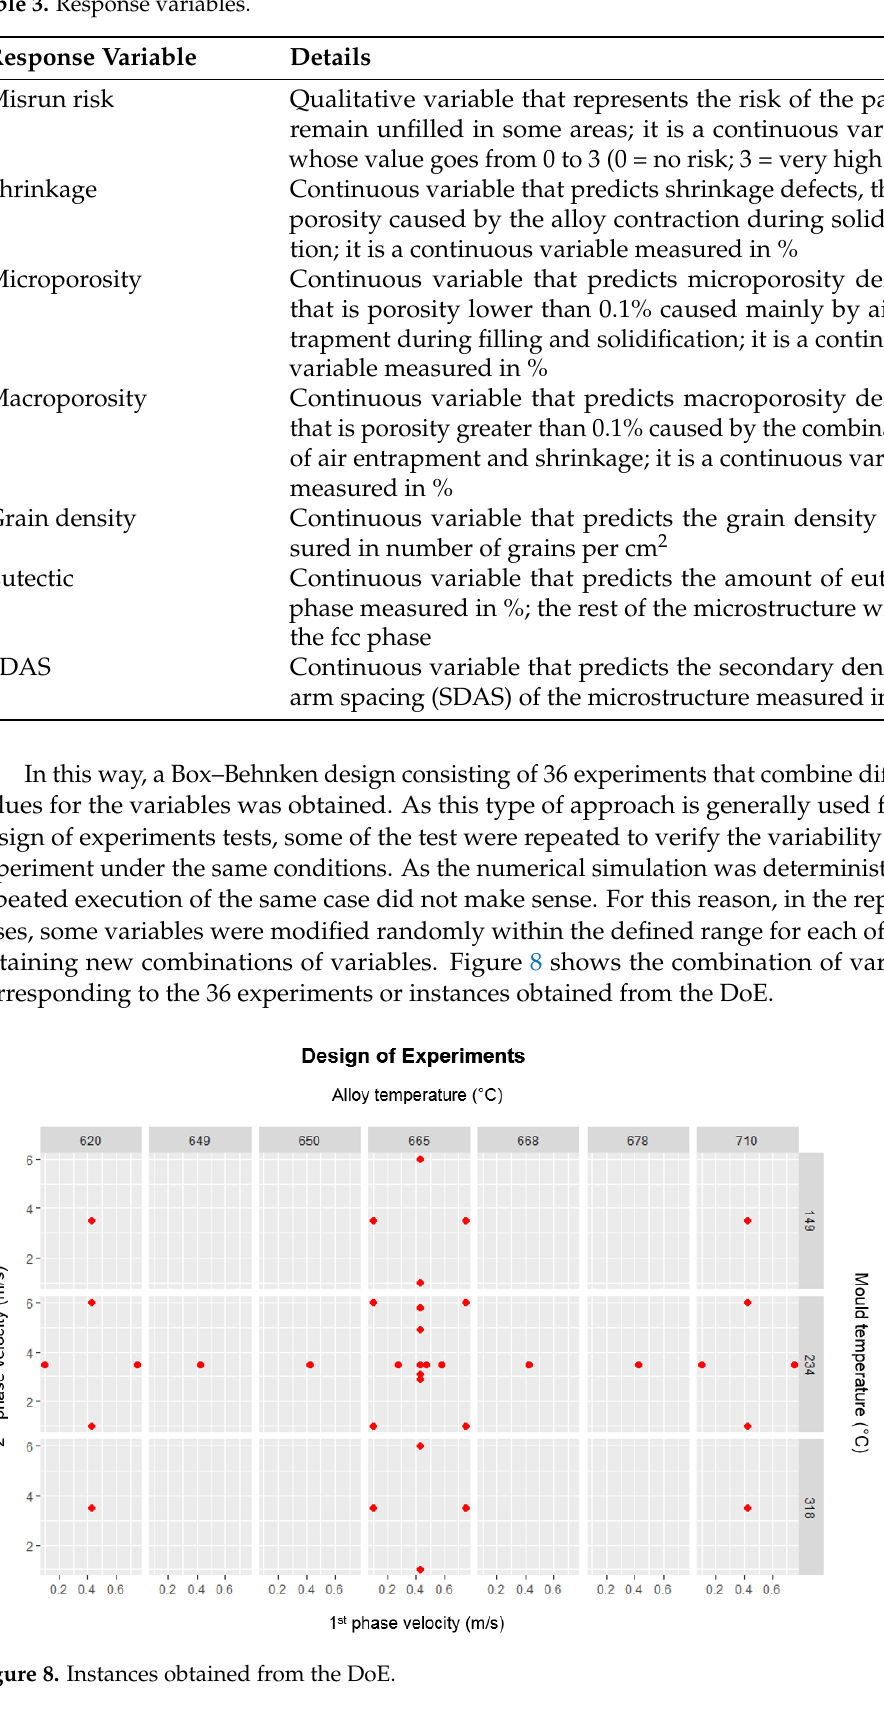
Table 3. Response variables.